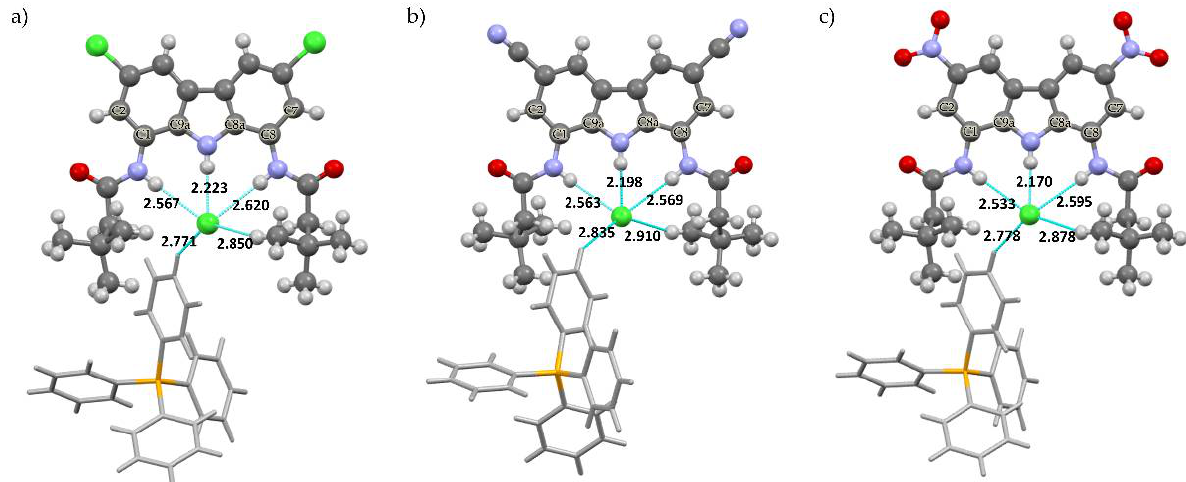
Figure 3. Crystals structures of ( a ) 2 × Cl − , ( b ) 3 × Cl − and ( c ) 4 × Cl − Table 1. Hydrogen bonding distances and selected torsion angles in the X-ray crystal structures of chloride complexes of 2 , 3 and 4 .